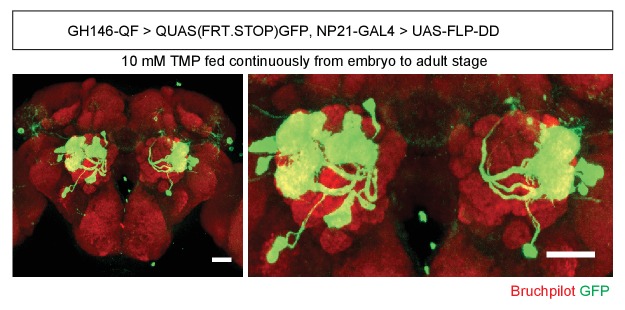
Intersection pattern between GH146-QF and NP21-GAL4 in flies fed with 10 mM TMP continuously.Scale bar = 25 μm.